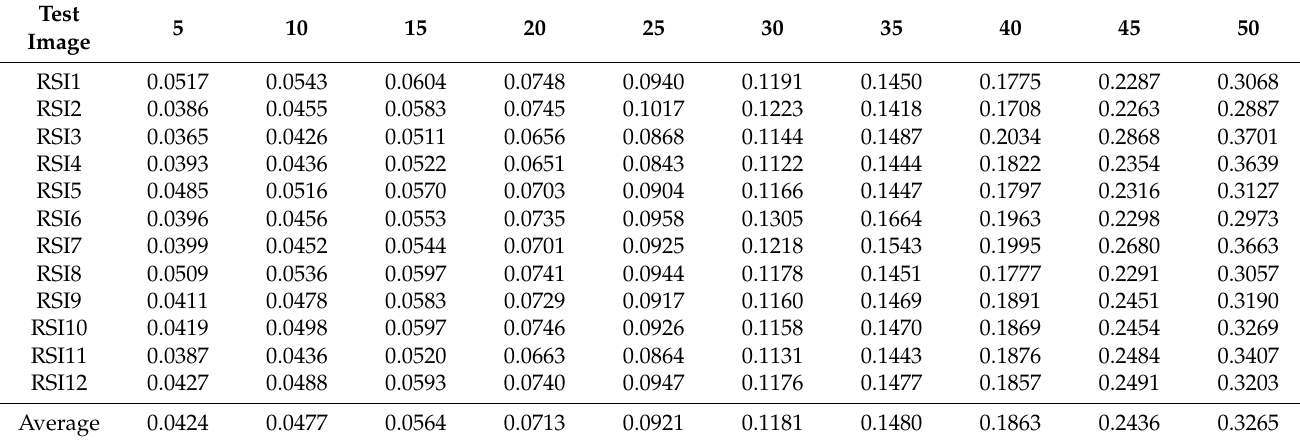
Table 2. Results of the MDSI metric obtained for 10 values of the Q parameter using the basic images (RSI #1–#12) presented in Figure 6.